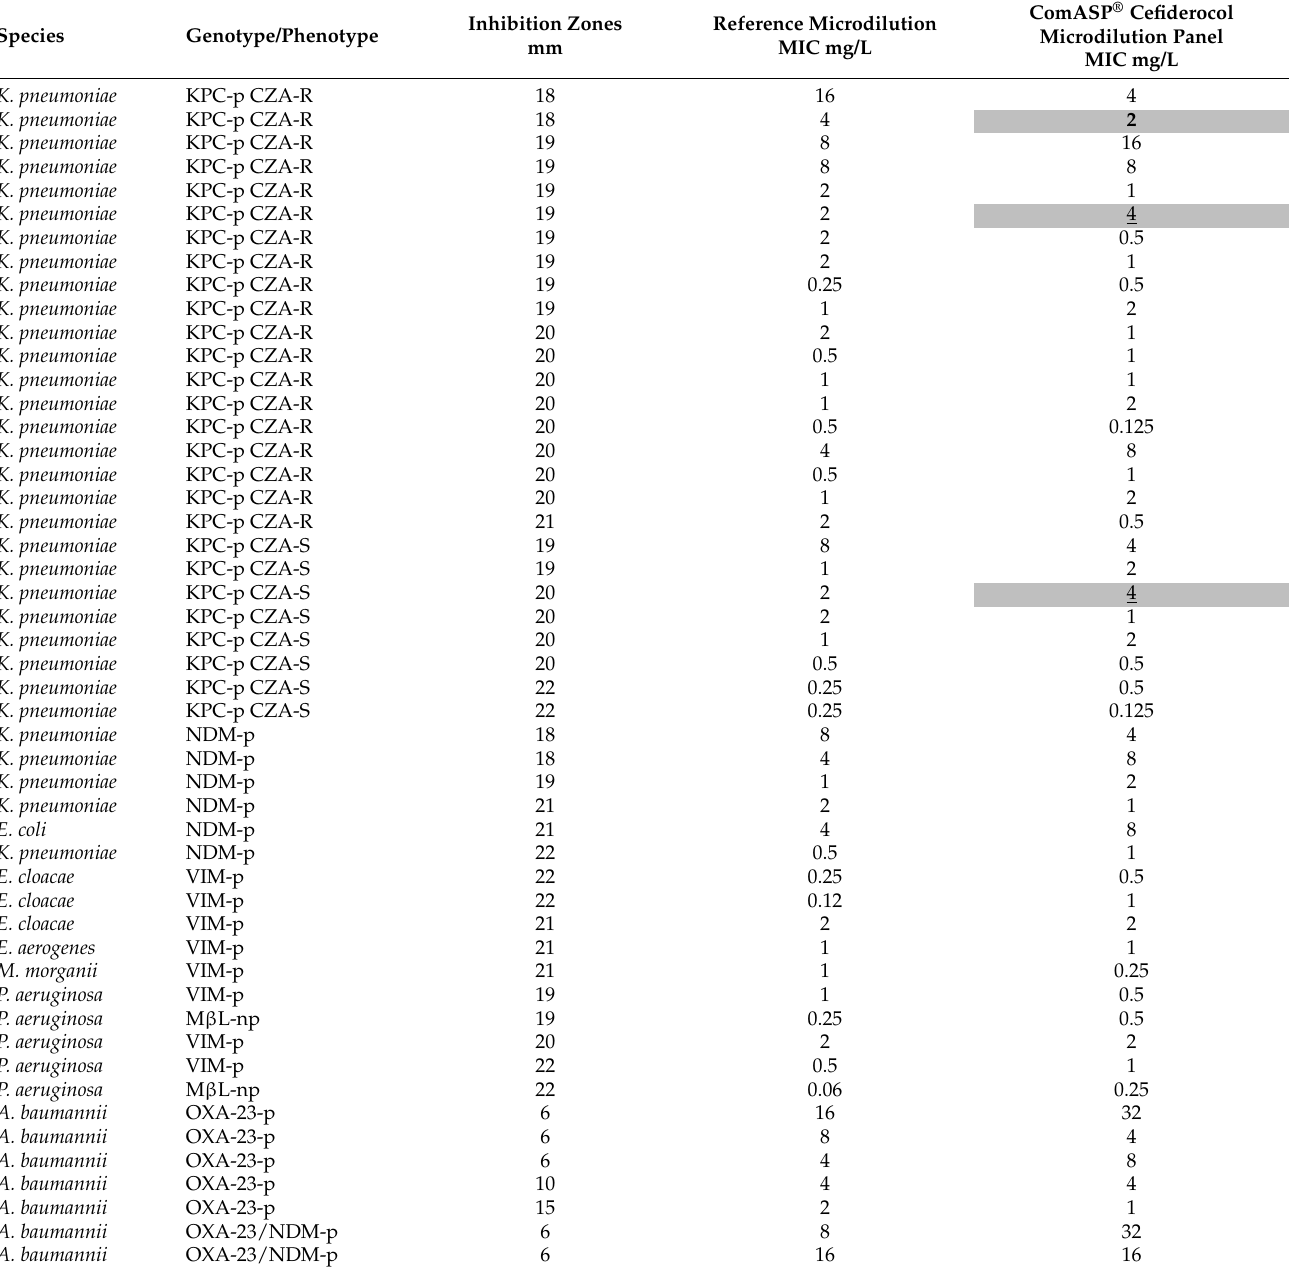
Table 2. MICs for cefiderocol using ComASP ® cefiderocol microdilution panel compared to reference broth microdilution on bacterial isolates showing cefiderocol inhibition zones inside the area of interpretative